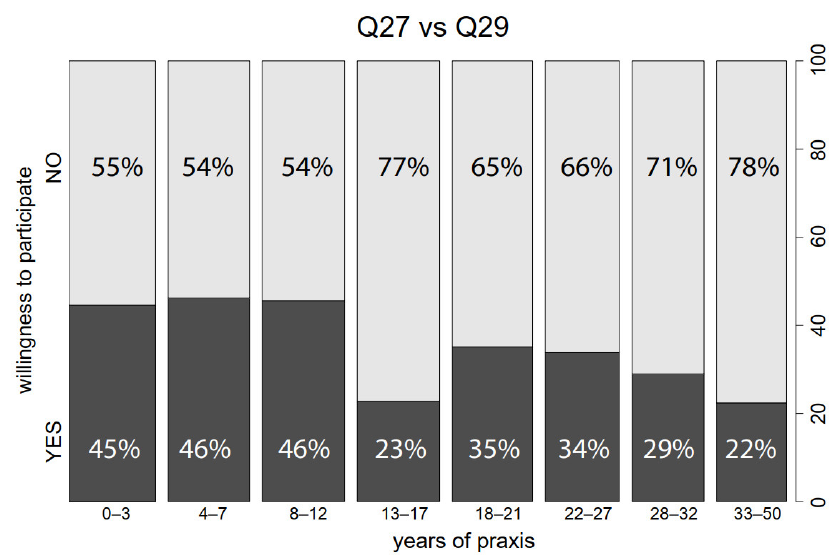
Figure 14. The influence of years of praxis on the willingness to participate.